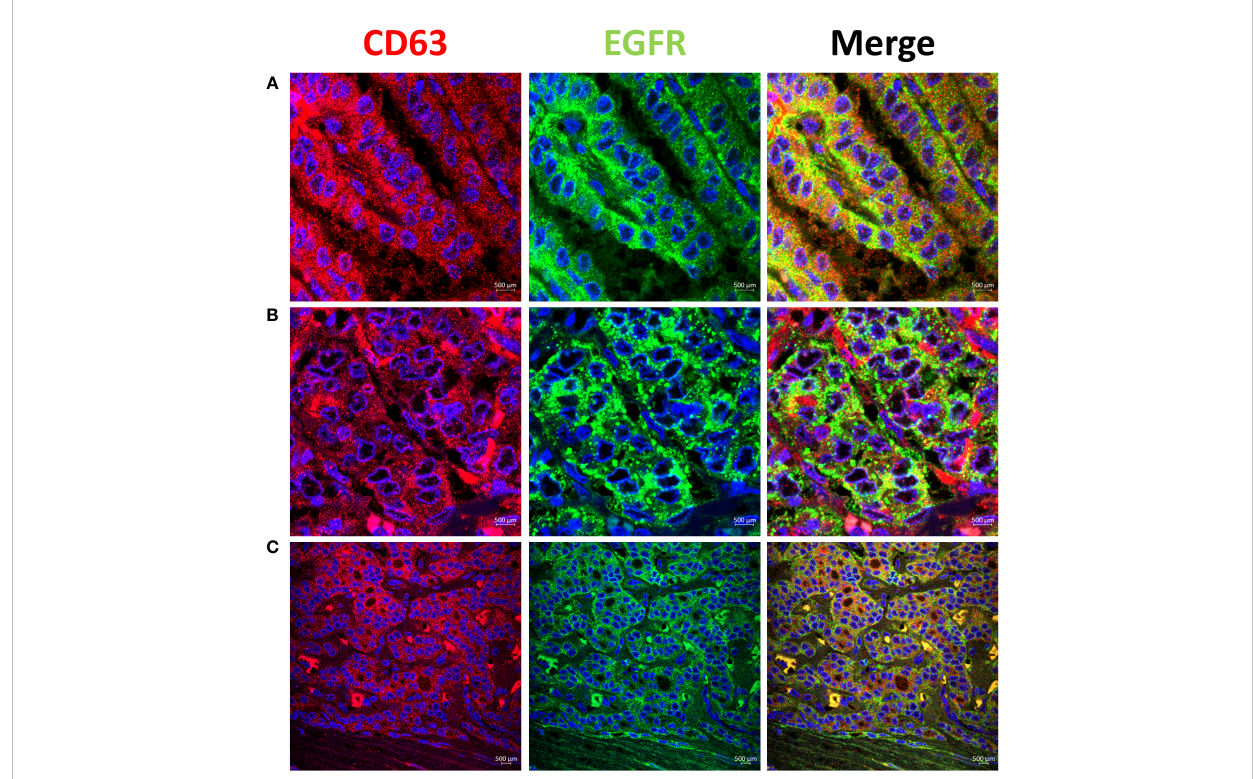
FIGURE 3 Representative samples stained with CD63 (red) and EGFR (green). CD63 colocalizes with EGFR in intracellular and extracellular vesicles in PTC (Colocalization coef fi cient >0.7) (A, B) . (C) In NIFTP CD63 positive vesicles appear mainly in the cytoplasm of tumor cells along with EGFR that shows enrichment at the plasma